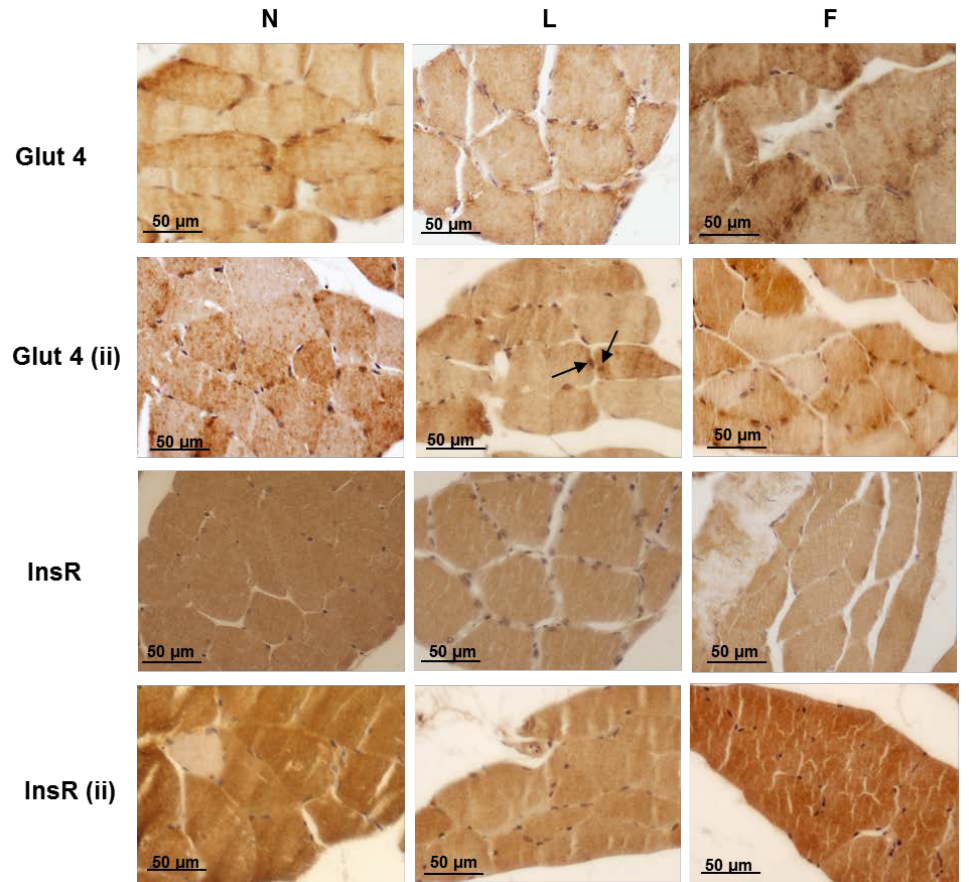
Figure 4. Skeletal muscle fibre immunohistochemical analysis of insulin resistance in rats fed a control diet (N), high-lard diet (L) or high-fish oil diet (F) Glut4: Without insulin administration, the immunostaining for Glut4 was evident in all groups of rats,